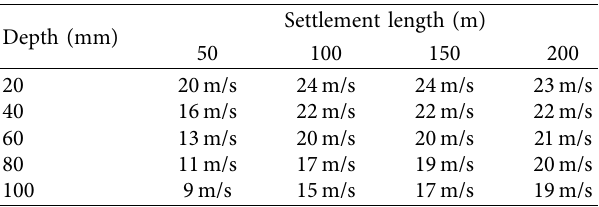
Table 4: Speed limit of the metro train due to different tunnel differential